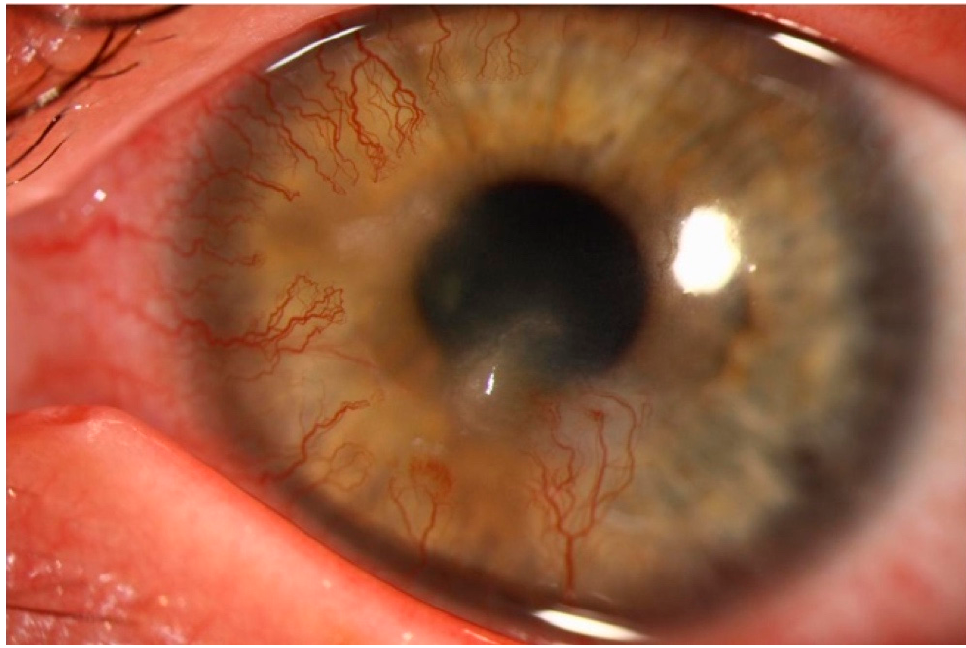
Figure 2. Corneal neovascularization with stromal scarring secondary to atopic keratoconjunctivi-